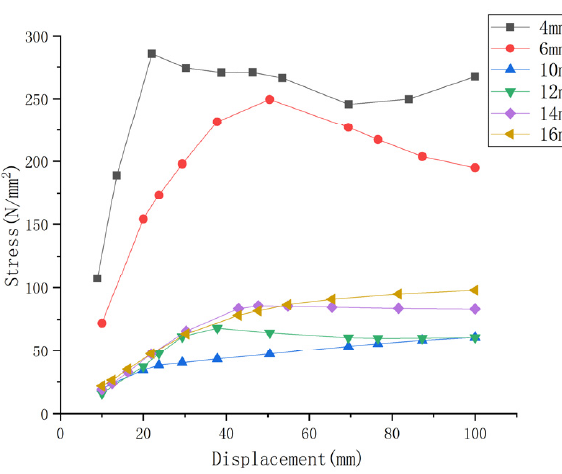
Figure 19. Stress history at N c .